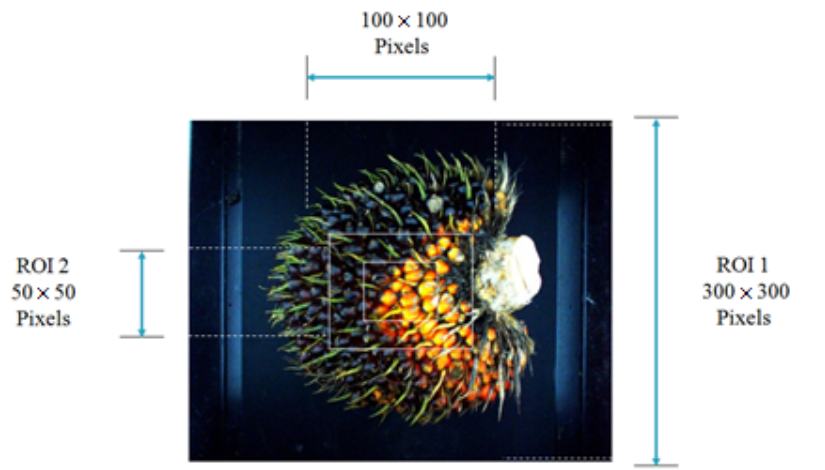
Figure 6. Three different regions of interest (ROI1, ROI2, ROI3) for the FFB ripeness of oil palm.